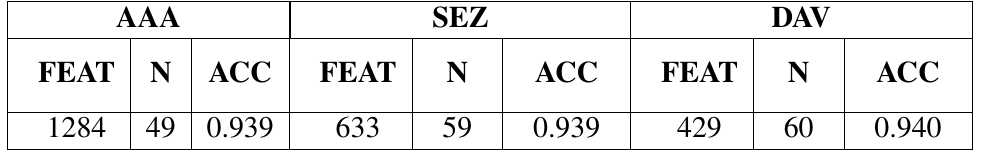
Table 5: Classification results with forward selection on top of t-test-based selection for a subset solution in which features are significant in at least 12 of the 21